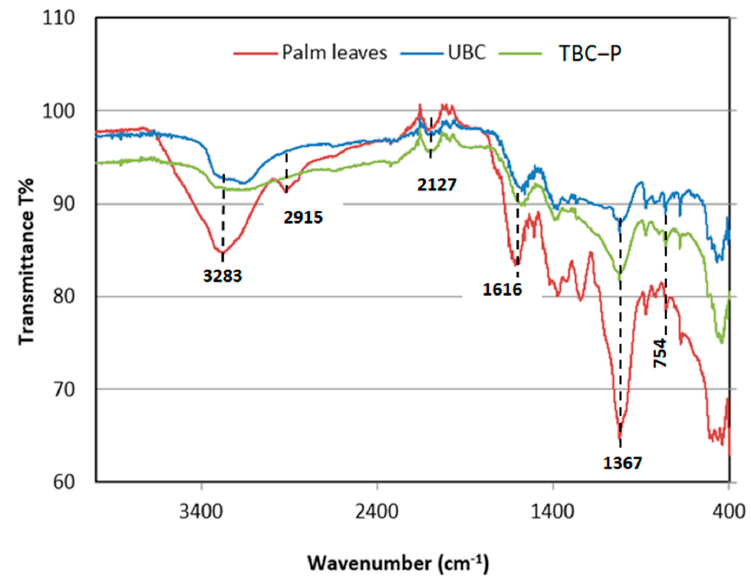
Figure 2. FTIR spectra of palm leaves, UBC and TBC-P. Table 1. FT-IR functional groups on palm leaves, UBC and TBC-P adsorbent.